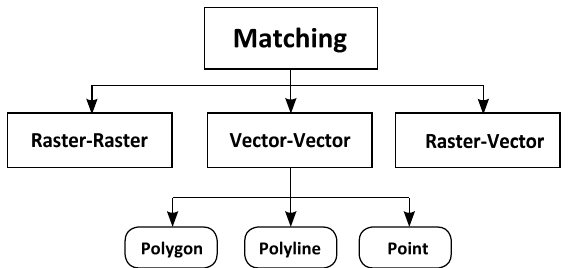
Fig. 1. Matching classification based on the data